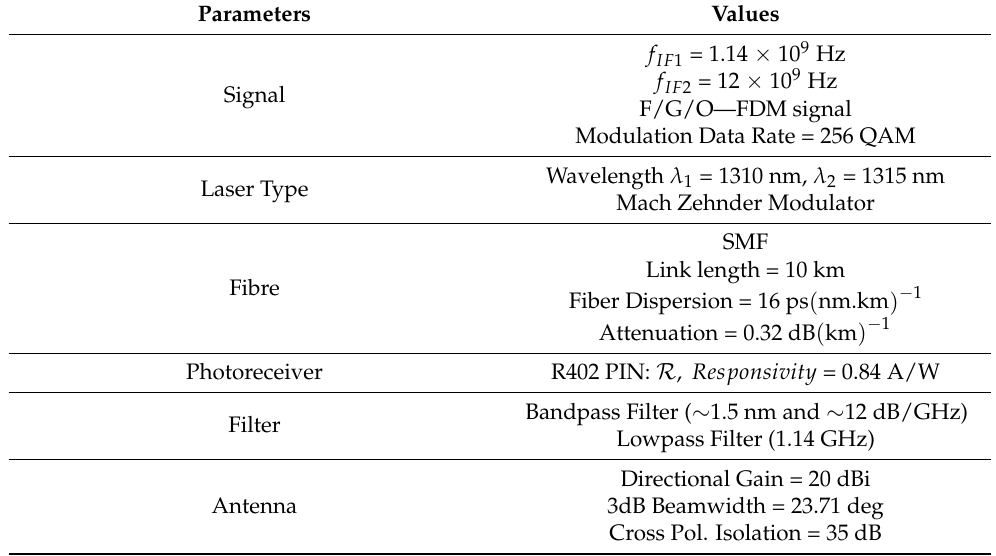
Table 1. Testbed link component